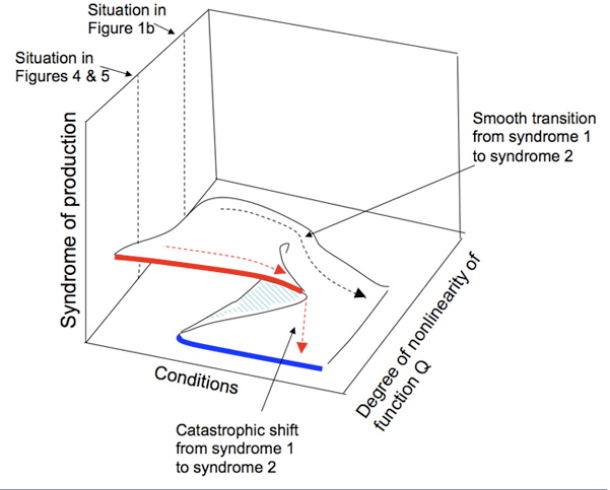
Fig. 6 . Overall summary of expected qualitative behavior of an agroecosystem with changing conditions (as stipulated by the simple dynamic model), the degree of nonlinearity of the model, and the resultant syndrome of production (i.e., state of the system). The point at which the function loses its monotonicity is referred to as a codimension 2